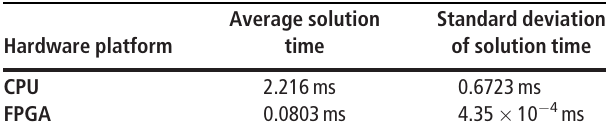
Table 6 Solution time information of QP solvers